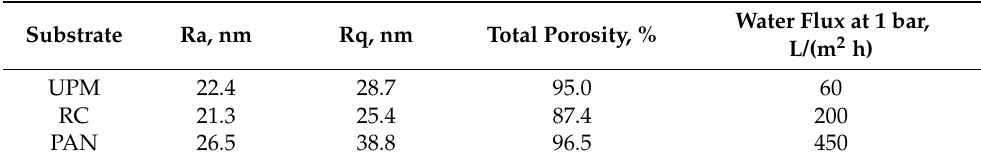
Figure 4. The cross-sectional and surface SEM micrographs and AFM images of the porous ( a ) UPM, ( b ) RC, and ( c ) PAN substrates. Table 4. The surface roughness parameters, total porosity, and water permeability of the porous sub-